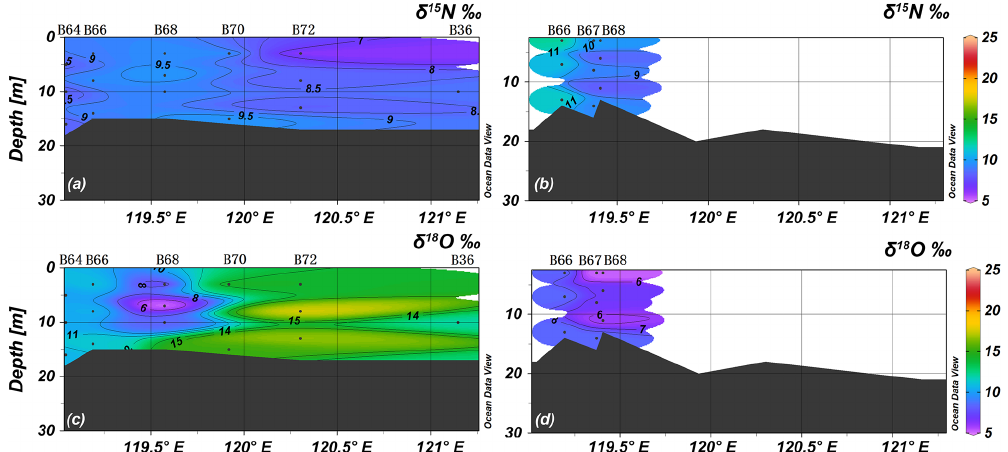
Figure 7. Nitrate isotopes (‰) of section 2 for spring (a, c) and summer (b, d)